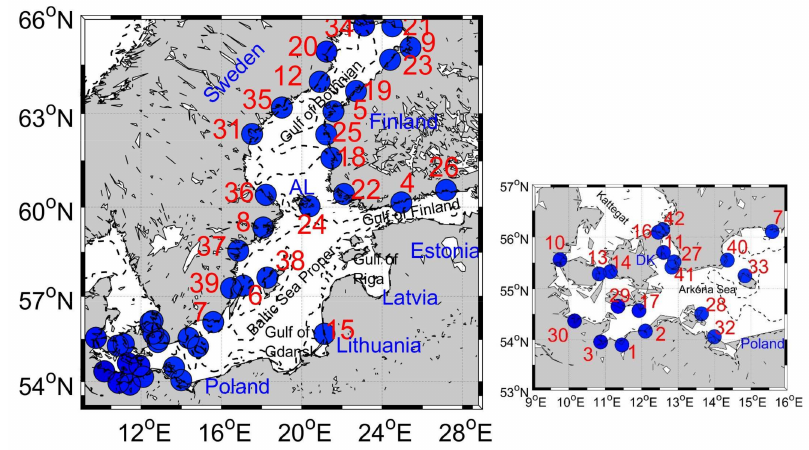
Figure 1. Map of the study area with bathymetry of 50 m overlaid. Locations of 42 selected tide gauges are shown as blue filled dots with their according numbers presented in Table 1. The zoom in region is the entrance of Baltic Sea. DK: Denmark, AL: